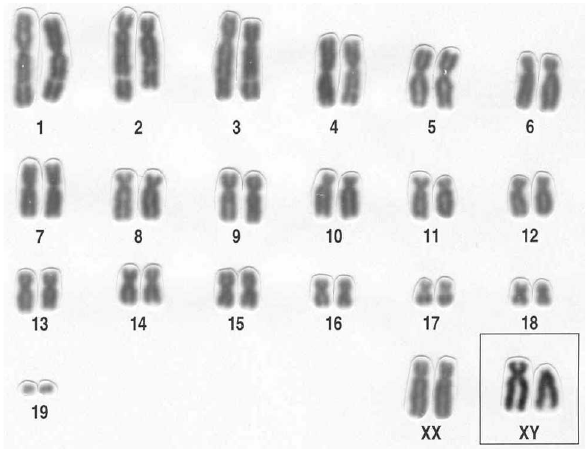
Figure 1 - Giemsa-stained karyotype of a S. a. ingrami female (2n = 40, NF = 74) showing secondary constrictions on long arms of pairs 1, 2, 3, and 17. In the square : the XY chromosomes of a